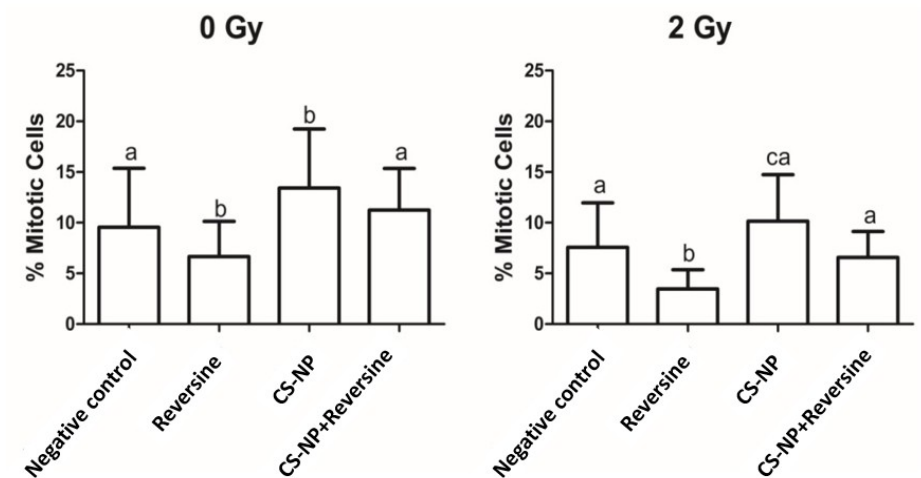
Figure 6. Mitotic index of non-irradiated (0 Gy) and irradiated (2 Gy X-rays) MCF-7 cells. The bars represent the mean values, whereas the lines indicate the standard deviation. Bars with same letter (a, b, c, d) are not significantly different (Tukey > 0.05). Mean values of non-irradiated (0 Gy) samples: negative control, 9.6 ± 5.8; reversine, 6.7 ± 3.4; CS-NP, 13.4 ± 5.8; CS-NP+ reversine, 11.24 ± 4.1. Mean values of X-ray irradiated (2 Gy) samples: negative control, 7.79 ± 4.4; reversine, 3.5 ± 1.8; CS-NP, 10.1 ± 4.5; CS-NP + reversine, 6.7 ± 2.5.